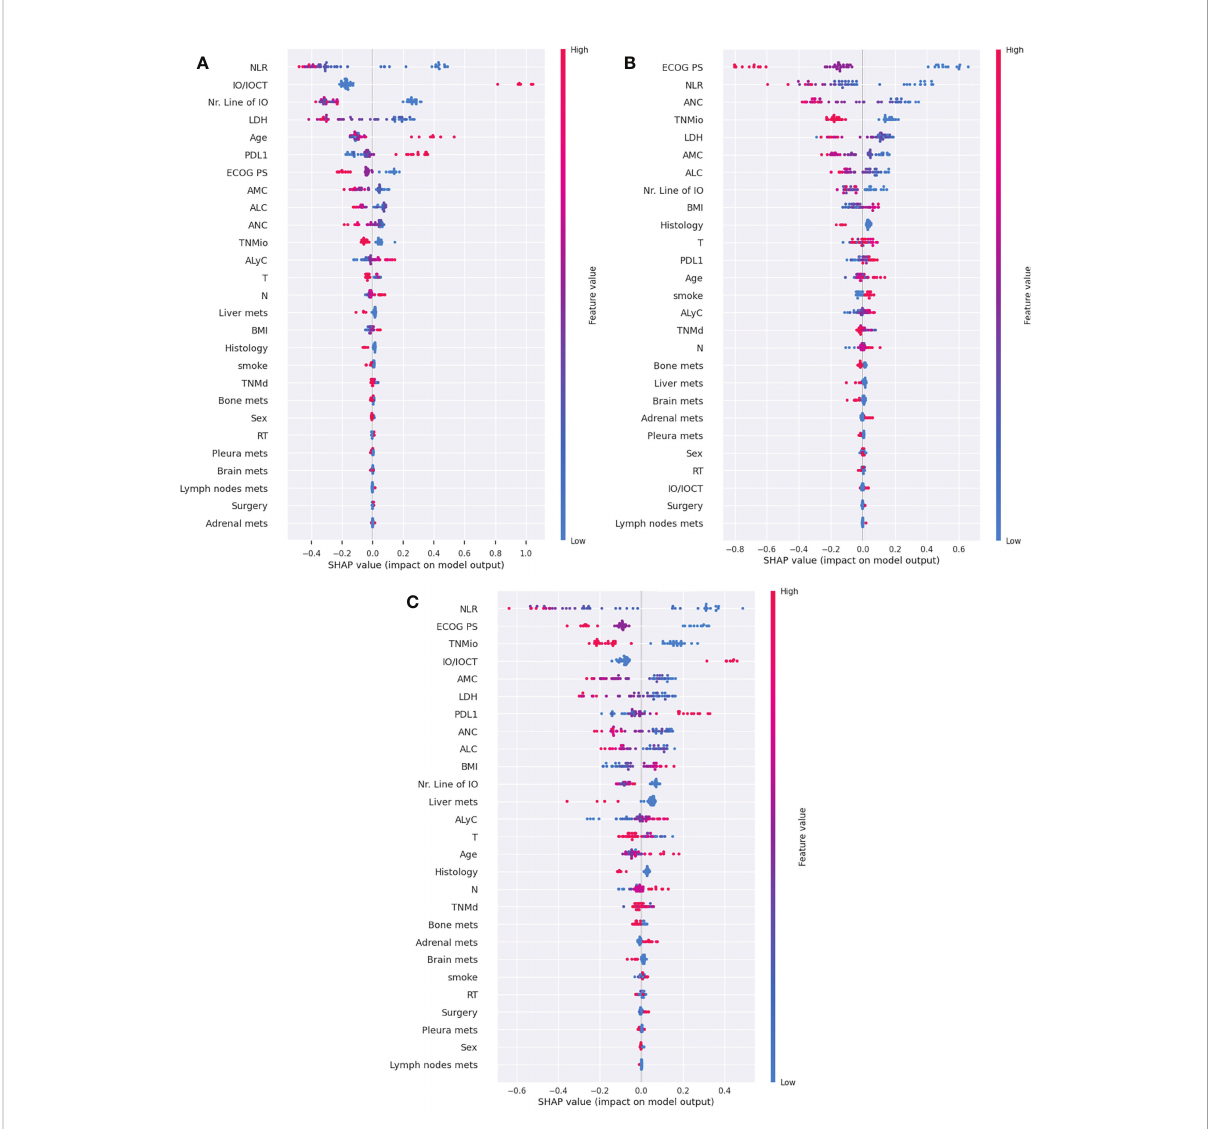
FIGURE 5 SHAP summary plots for the CB model for three main outcomes: DCR (A) , OS6 (B) and TTF3 (C) . IO/IOCT, immuno-oncologic treatment/ immuno-oncologic and chemotherapy treatment; PDL-1, programmed death ligand-1; ECOG PS, eastern cooperative oncology group performance status; NLR, Neutrophil-to-lymphocyte ratio; AMC, absolute monocytes count; ALC, absolute leucocytes count; ANC, absolute neutrophils count; ALyC, absolute lymphocytes count; TNMd, TNM staging at diagnosis; TNMio, TNM staging at baseline of IO; BMI, body mass index; RT,